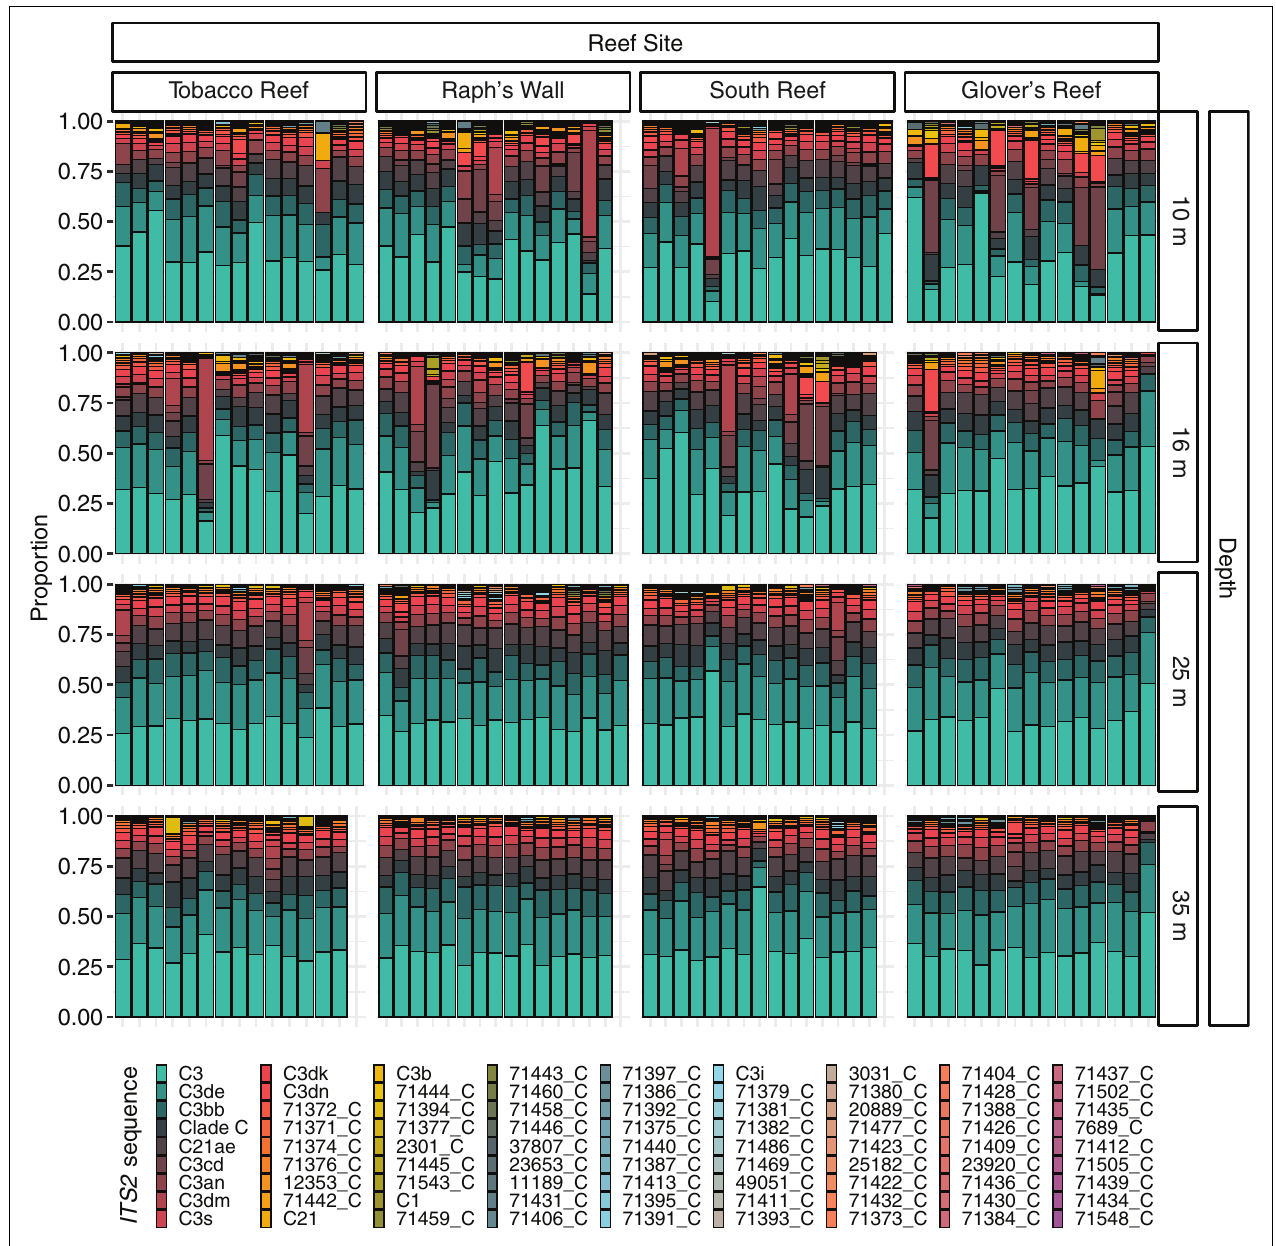
FIGURE 3 | Normalized relative proportion of ITS2 sequences from Montastraea cavernosa samples. Only the most abundant ( > 0.01% of all reads) sequences are displayed ( n = 81). ITS2 sequences are listed in order of overall abundance. Sequences not used in the definition of ITS2 type profiles are named with a unique database ID number followed by a letter which refers to the genus the sequence is from (e.g., 71372_C is a sequence from the genus Cladocopium with the database ID